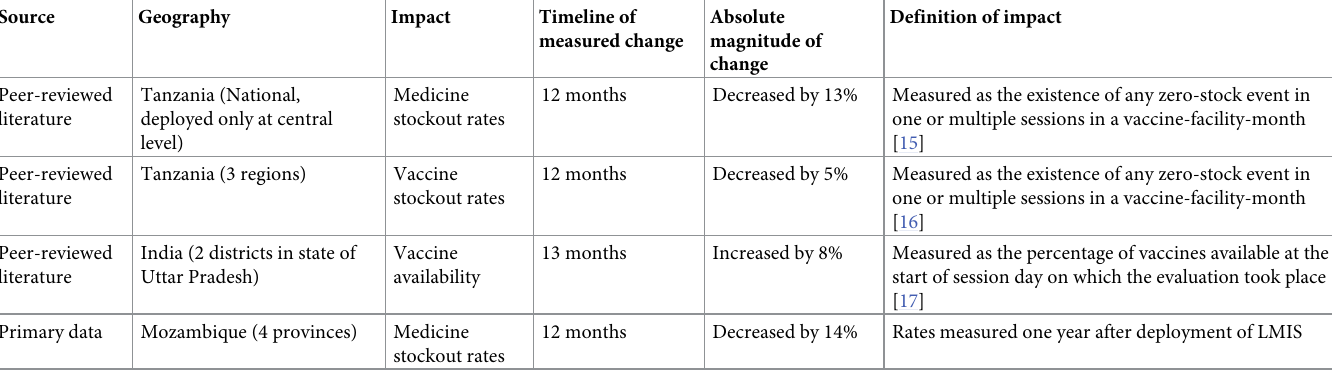
Table 1. Summary of the impact of digitalized, last-mile Logistics Management Information Systems (LMIS) on commodity stock levels.